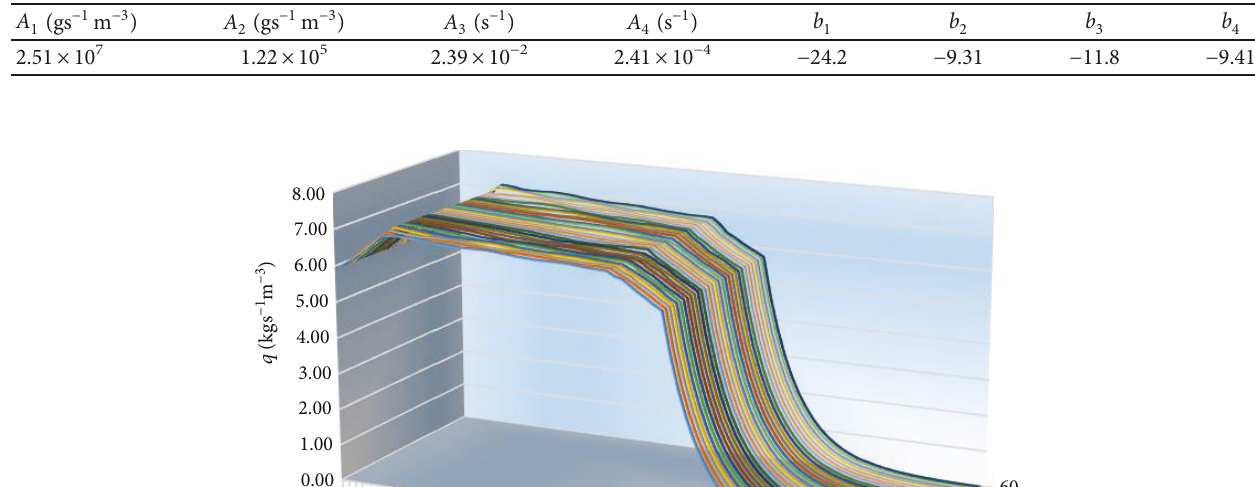
, A , A , and A 1 2 3